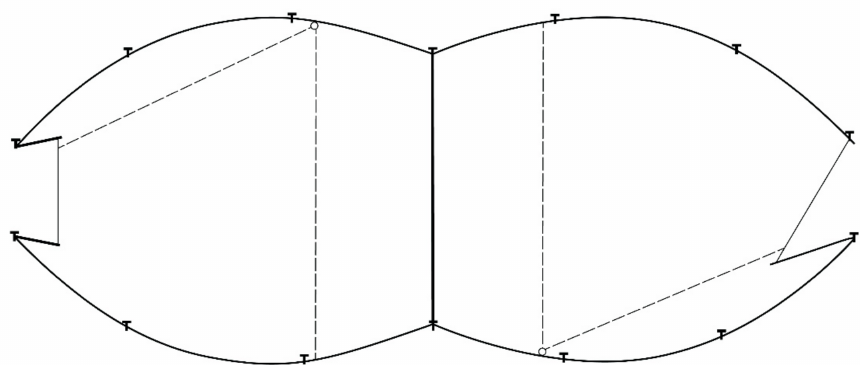
Figure 2. Corral trap configuration (9.75 m (l) × 2.4 m (w) × 1.5 m (h)) that includes saloon-style gate ( left ), single spring gate ( right ), and trip wires (dashed lines) used on Oswalt Road and Hoffmann ranches, Love County, Oklahoma, USA to trap wild pigs ( Sus scrofa ).